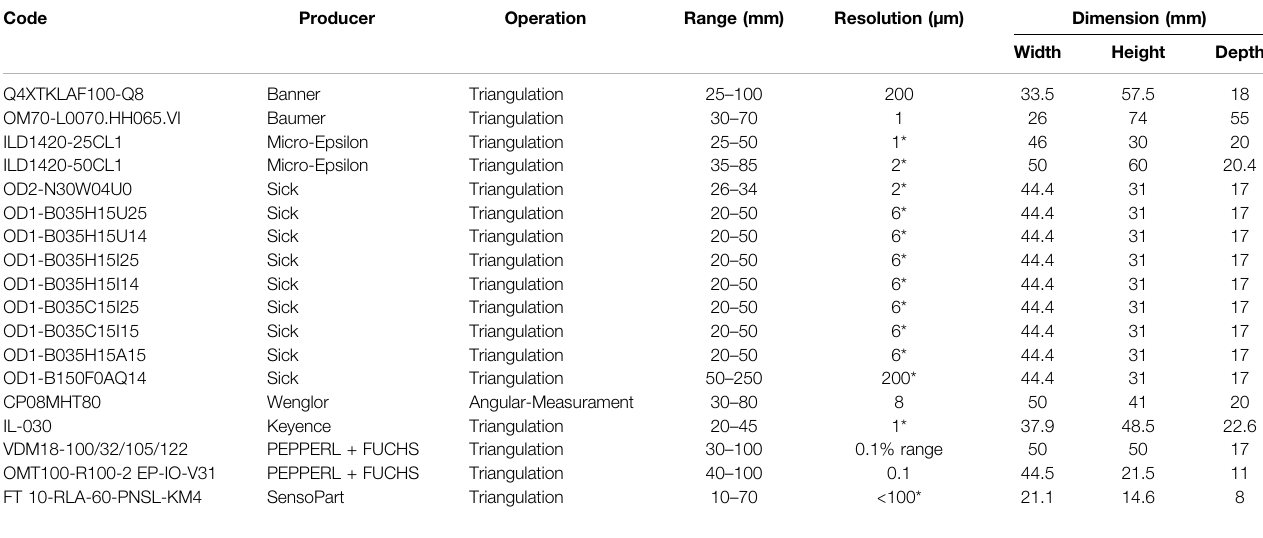
TABLE 2 | List of sensors technical characteristics (*repeatability).